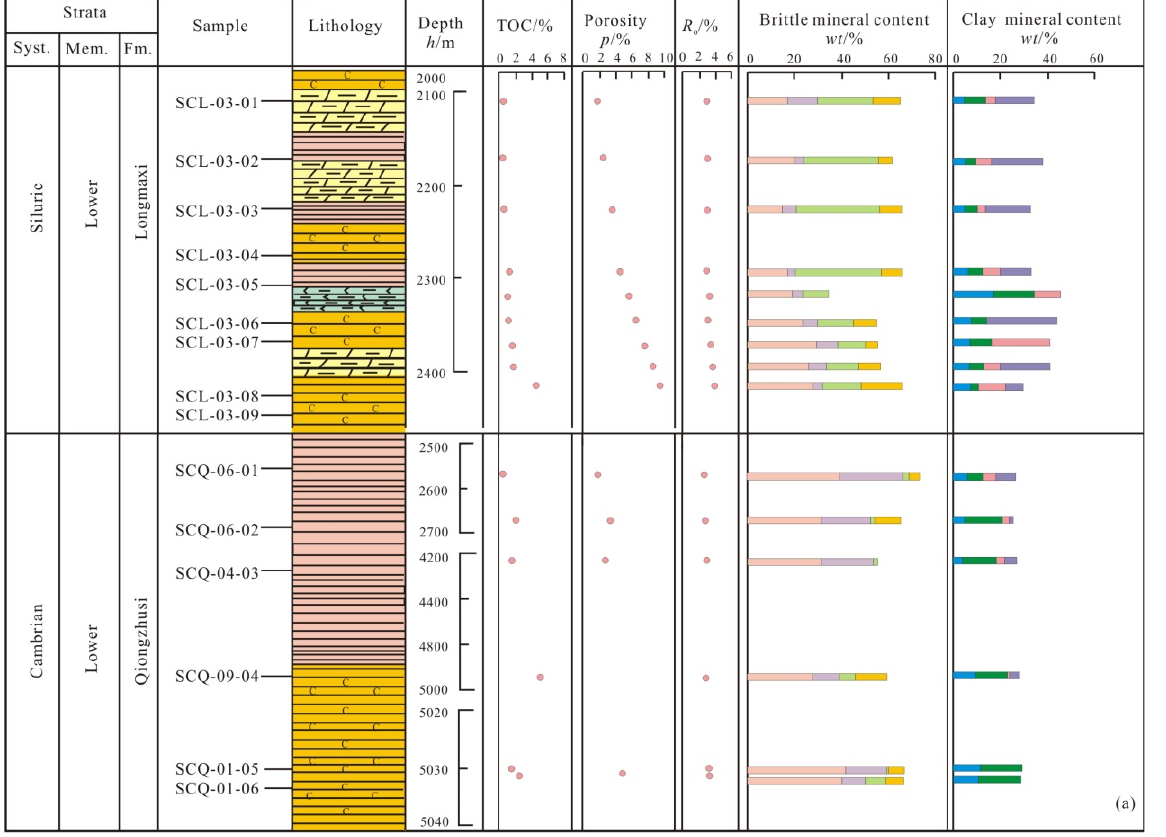
Figure 2. Geochemical characteristics of the Lower Paleozoic shale from southern Sichuan Basin ( a ) and northern Gui- zhou province ( b ).